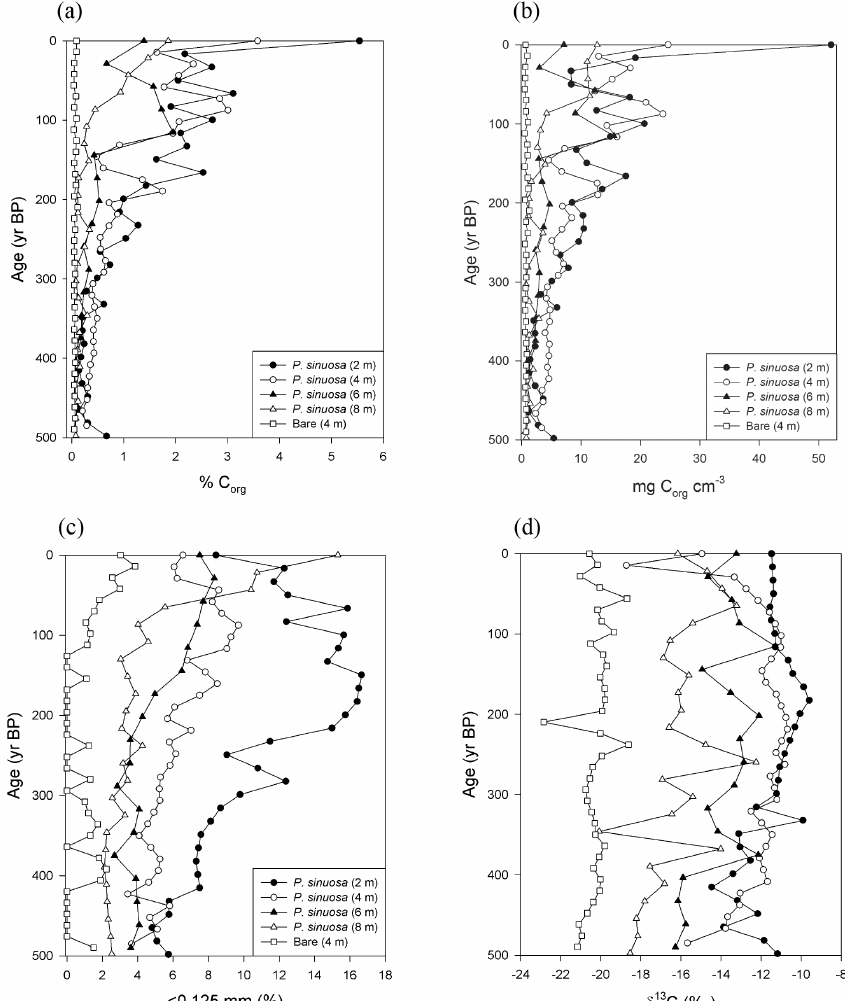
Figure A1. Substrate properties plotted against age at Cockburn Sound ( P. sinuosa cores at 2, 4, 6 and 8m depth and bare sediment core at 4m depth). (a) Organic carbon content (%); (b) organic carbon stocks (mgC org cm − 3 ) ; (c) sediment grain size <0.125mm; (d) δ 13 C signatures (‰) of organic carbon.